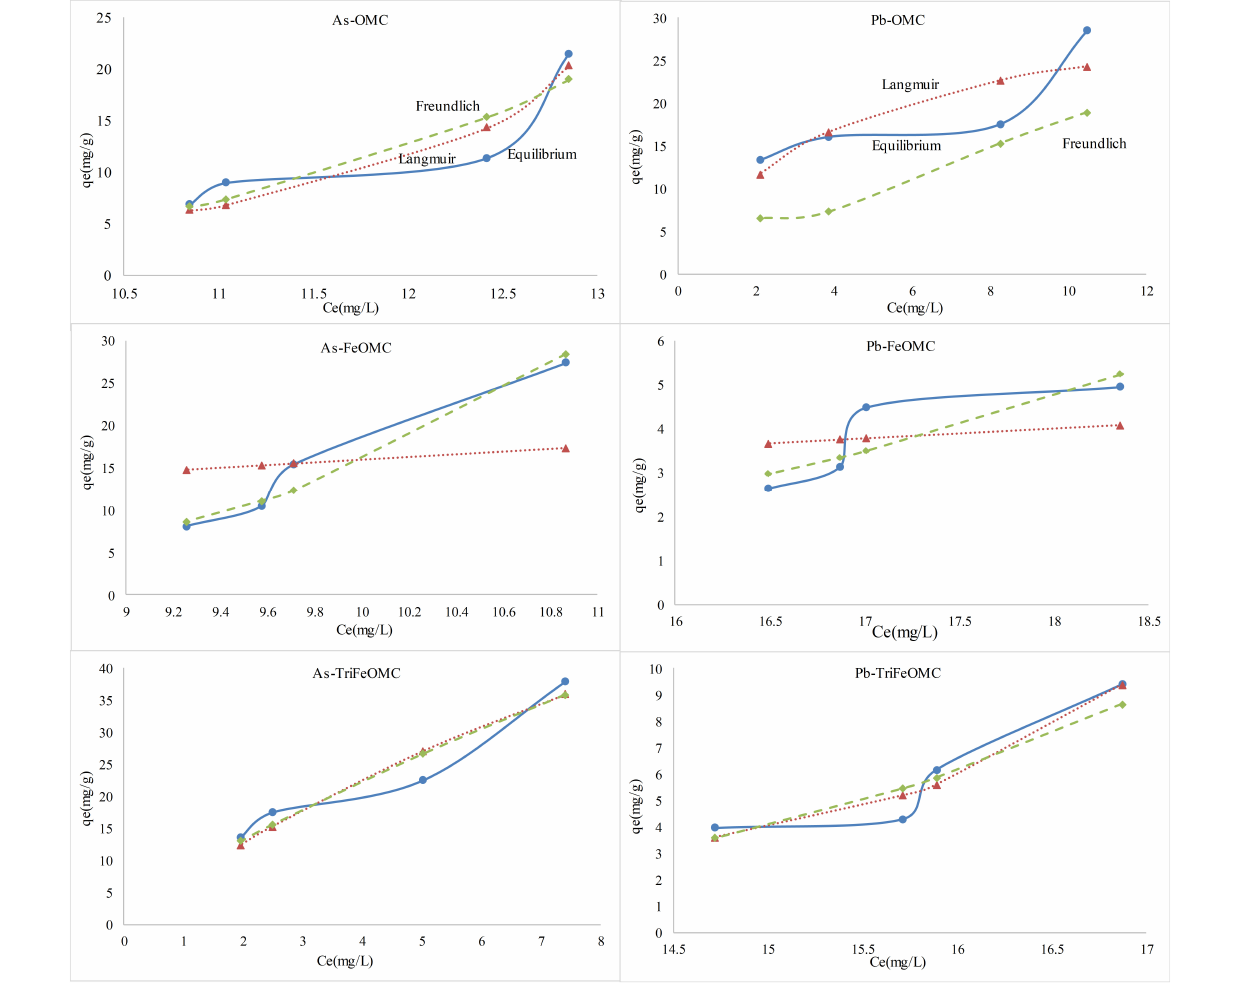
and 120 min at optimum pH (7) and at constant temperature of 25 ◦ C. The initial concentrations of Lead (Pb) for the same experiment were 11.15, 11.46, and 11.68 mg/L with 0.03 g of OMC, FeOMC, and TriFeOMC with the same temperature, time, and pH. The study of adsorption kinetics at the solid-phase interface is of major importance for determining the uptake rate of the prepared material (adsorbate). The pseudo-first-order kinetic model in non-linear (Eq. 7) equation form is given